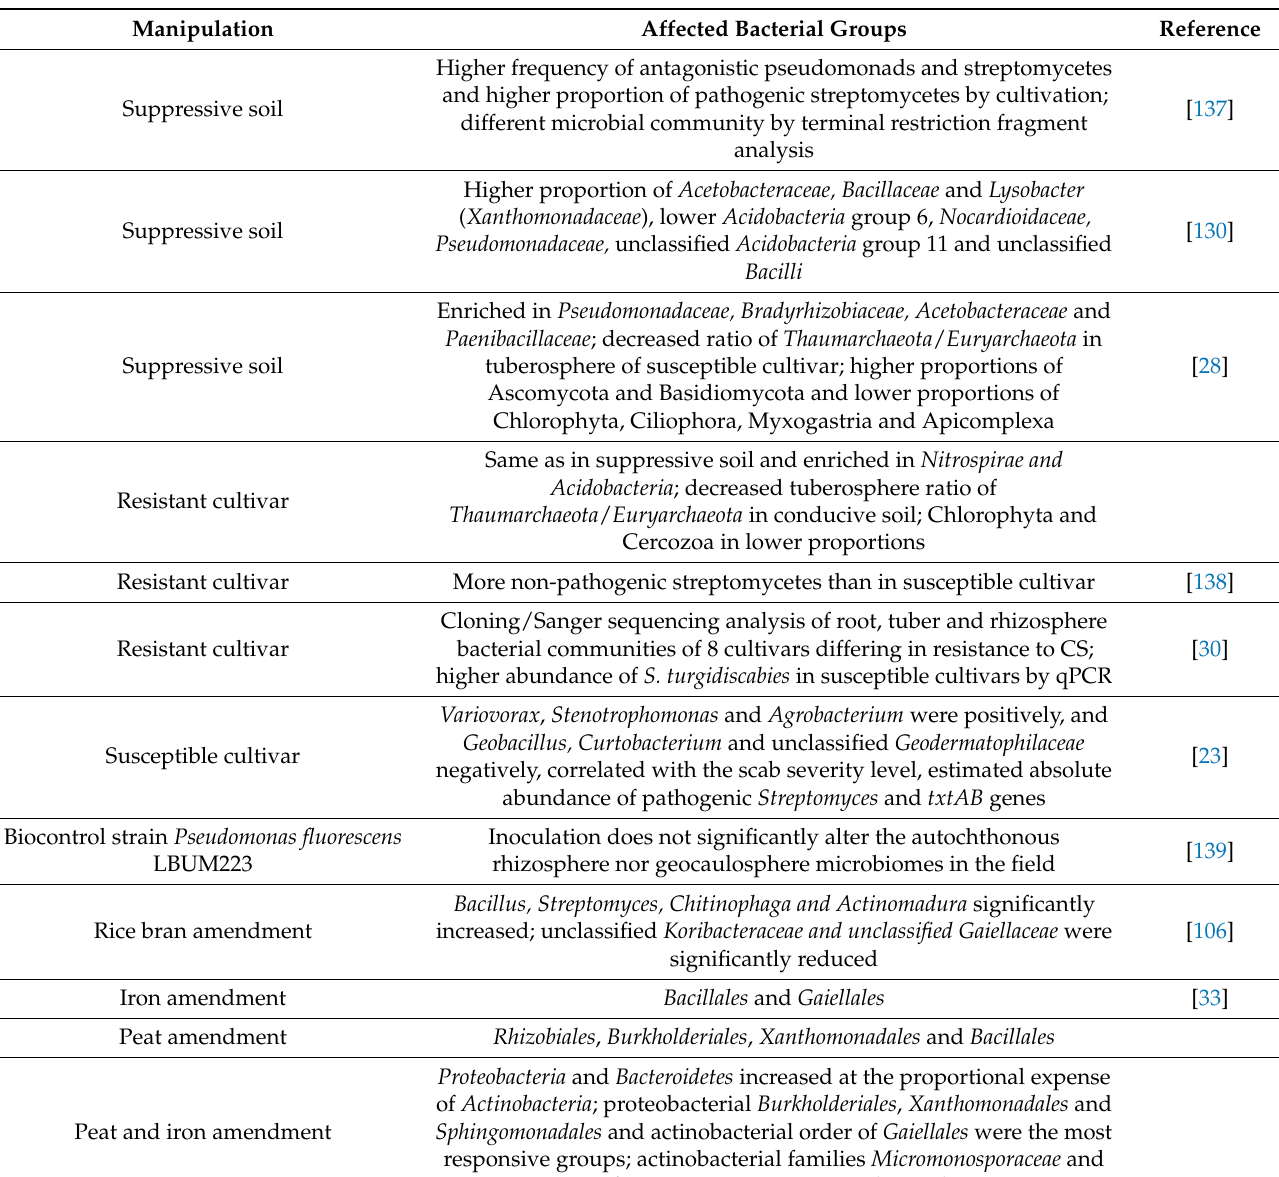
Table 3. Microbial community changes associated with lowered CS severity due to soil suppressivity, potato cultivar or soil